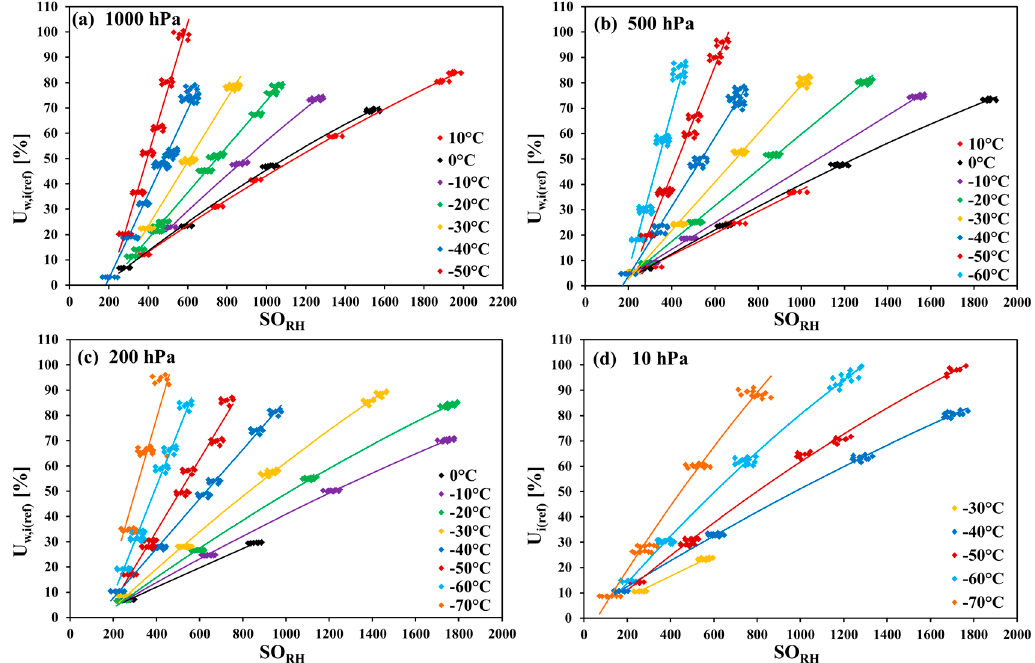
Figure 2. Temperature dependencies of the SHT75 sensors in CO 2 (regression lines fitted to measurement points collected from all tested sensors at different temperature ‐ pressure combinations) at pressures from 10 hPa to 1000 hPa.